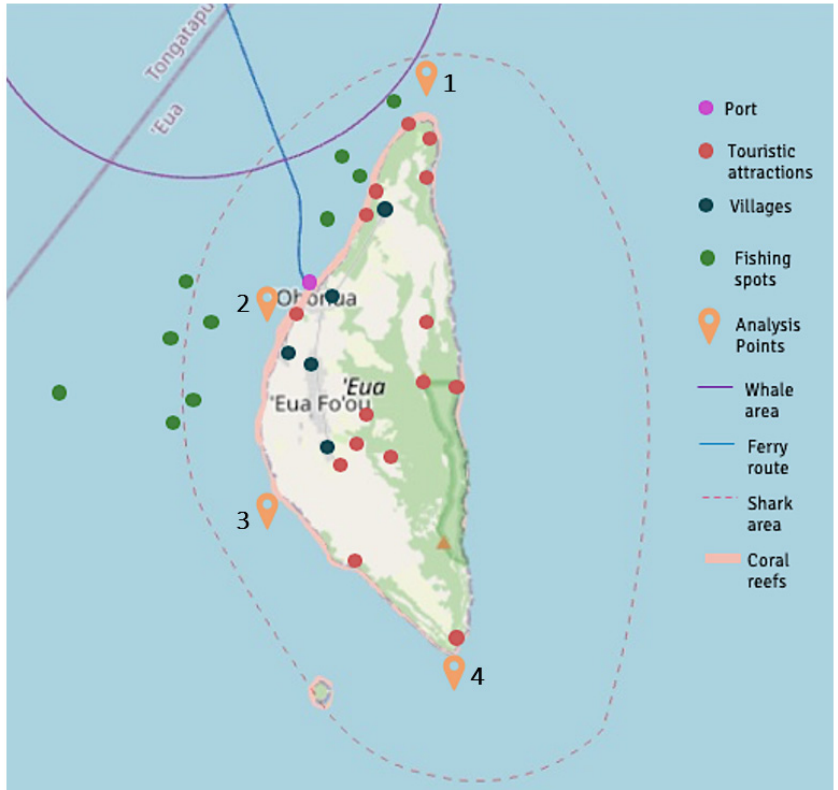
Figure 8. Map of ‘Eua containing important sites and possible constraints. The map graphically presents the result of the PESTEL analysis and the potential sites for a WEC. Table 3. Wave climate and wave energy parameters for each point.